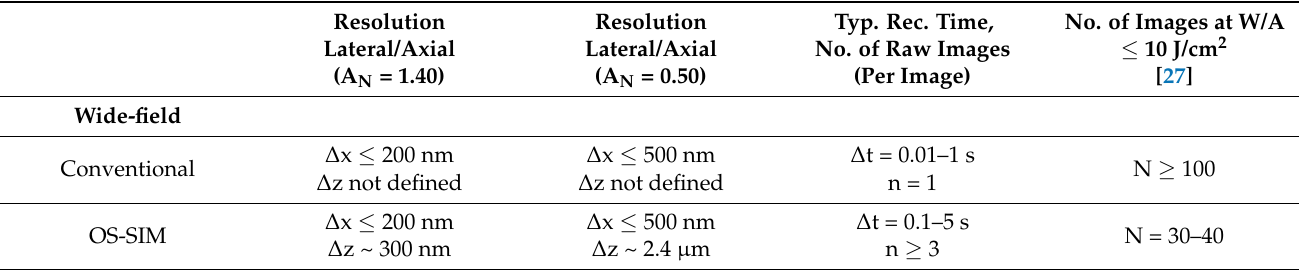
Table 1. Summary on wide-field and laser scanning techniques, including lateral ( ∆ x) and axial ( ∆ z) resolution for high